Question: Name the type of graph shown.
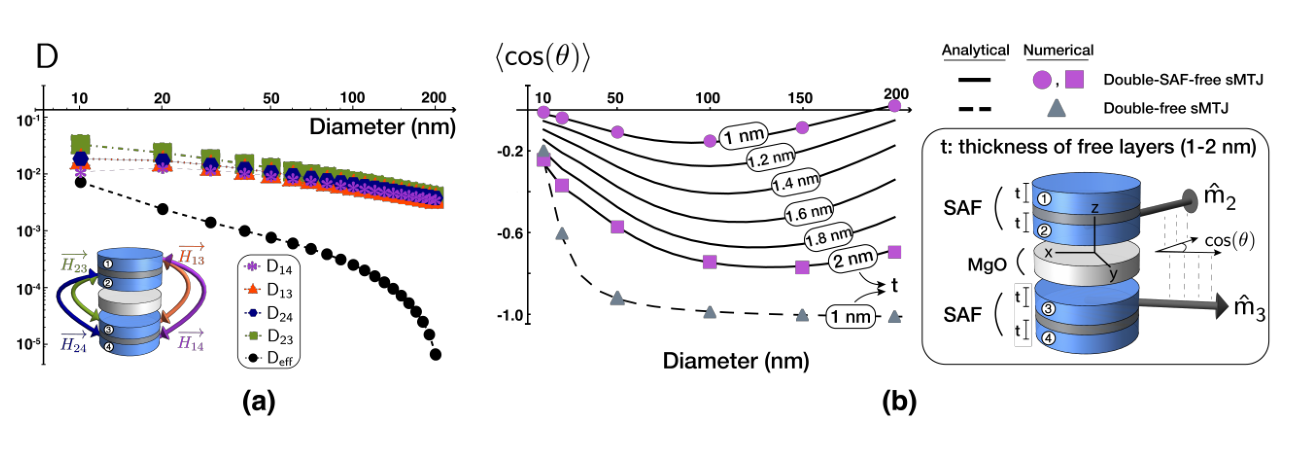
Answer: line